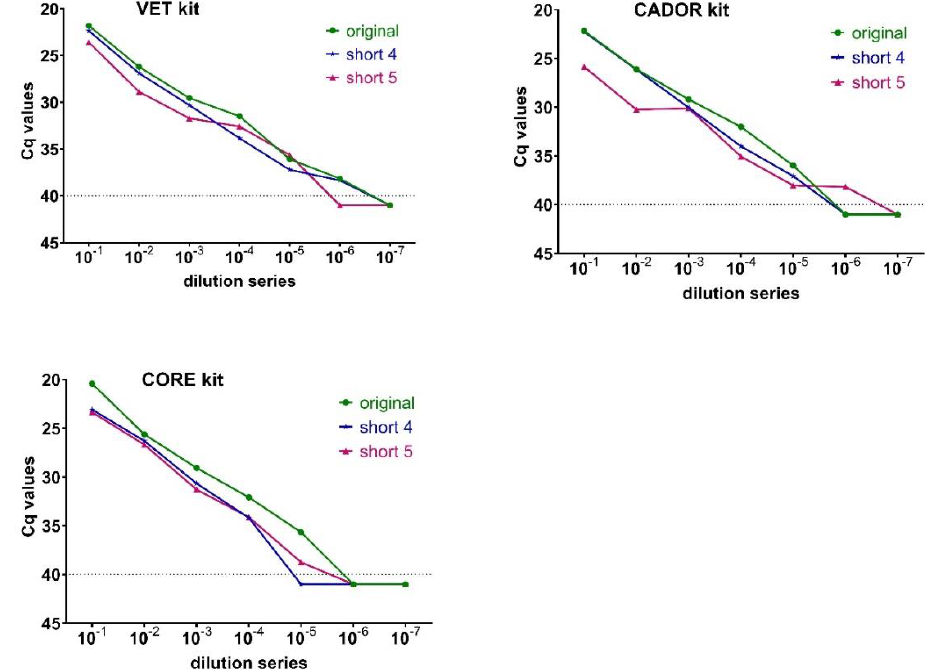
Figure 2. Test series for the establishment of a speed-optimized extraction protocol: differences in the Cq-values of the original (“original”) and the maximum shortened protocols (“short 4” and “short 5”) for three different extraction kits: VET kit; CADOR kit and CORE kit using a BioSprint 15 platform.